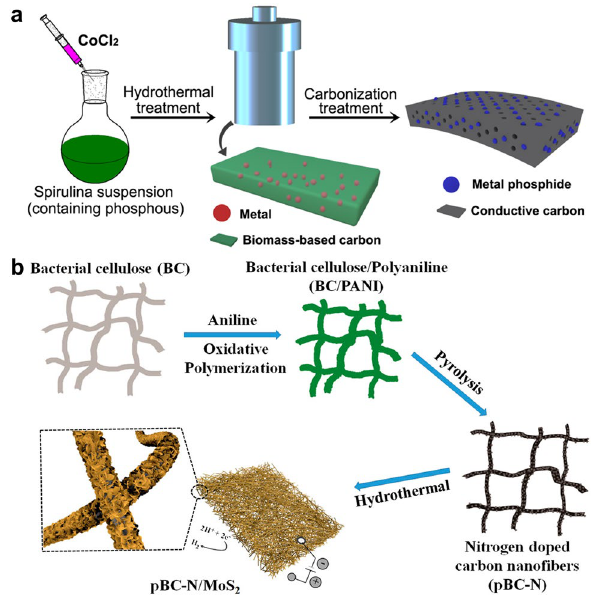
Fig. 4 a Scheme of synthesis of cobalt phosphides decorated spir‑ ulina‑derived porous N‑doped carbon matrix (Co 2 P/NC)